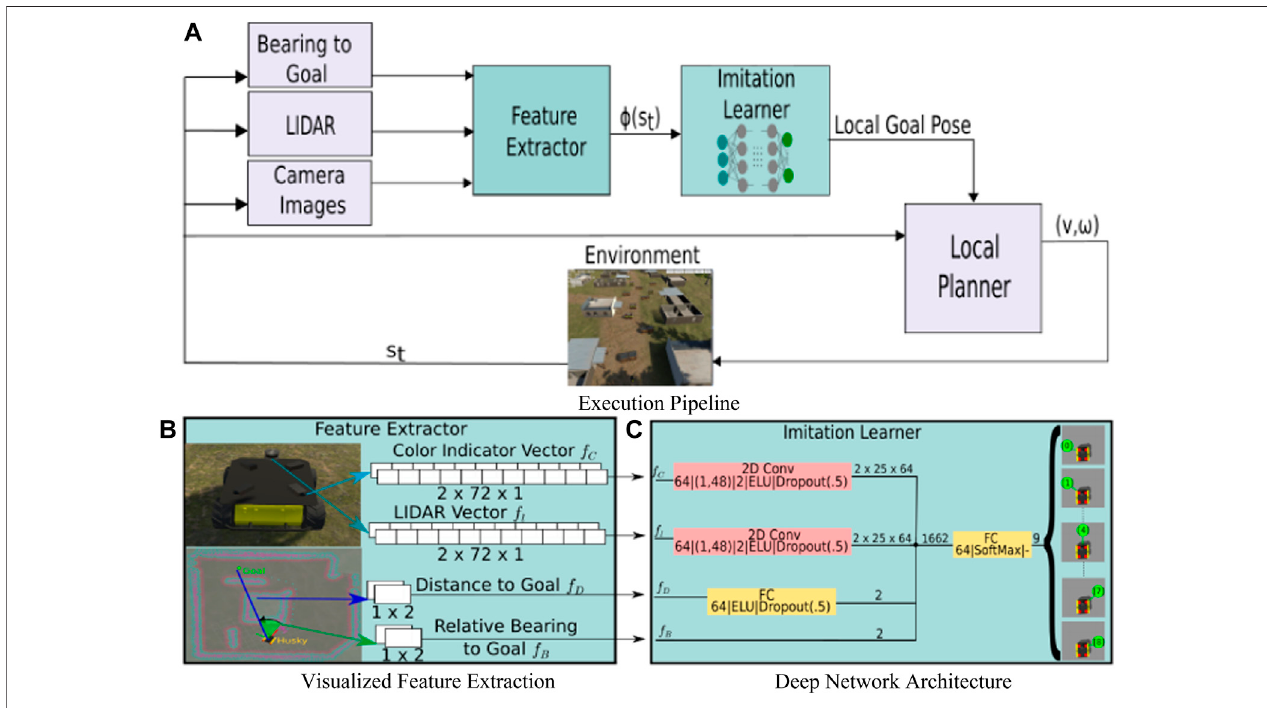
FIGURE 1 | (A) Proposed execution pipeline for improved autonomous navigation: a neural network is inserted before the local planner in the default ROS navigationstack.ThisnetworkistrainedusingBCfromhumandemonstrationstomapcurrentstateandtaskinformationtogoalsforthelocalplanner. (B) Visualizationof image features, lidar data, distance to goal, and relative bearing to goal features are collected and transformed to low dimensional inputs to the policy model. (C) The Imitation Learning module that maps the observations of the current state, pre-processed in the feature extraction step, to a local goal for the local planner.